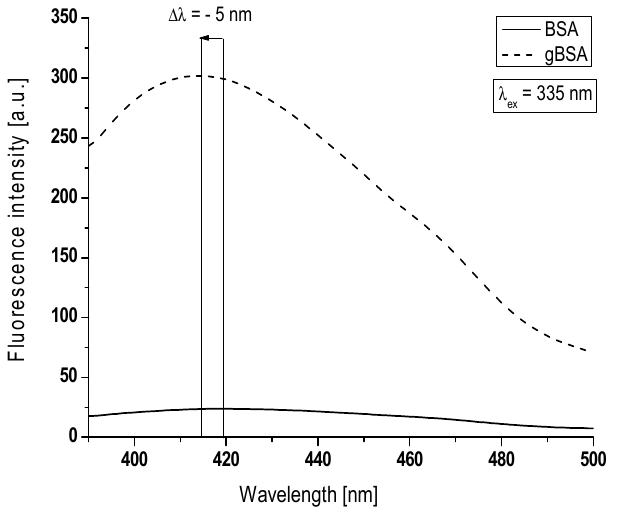
Figure 2. AGEs emission fluorescence spectra of non-glycated and glycated bovine serum albumin at